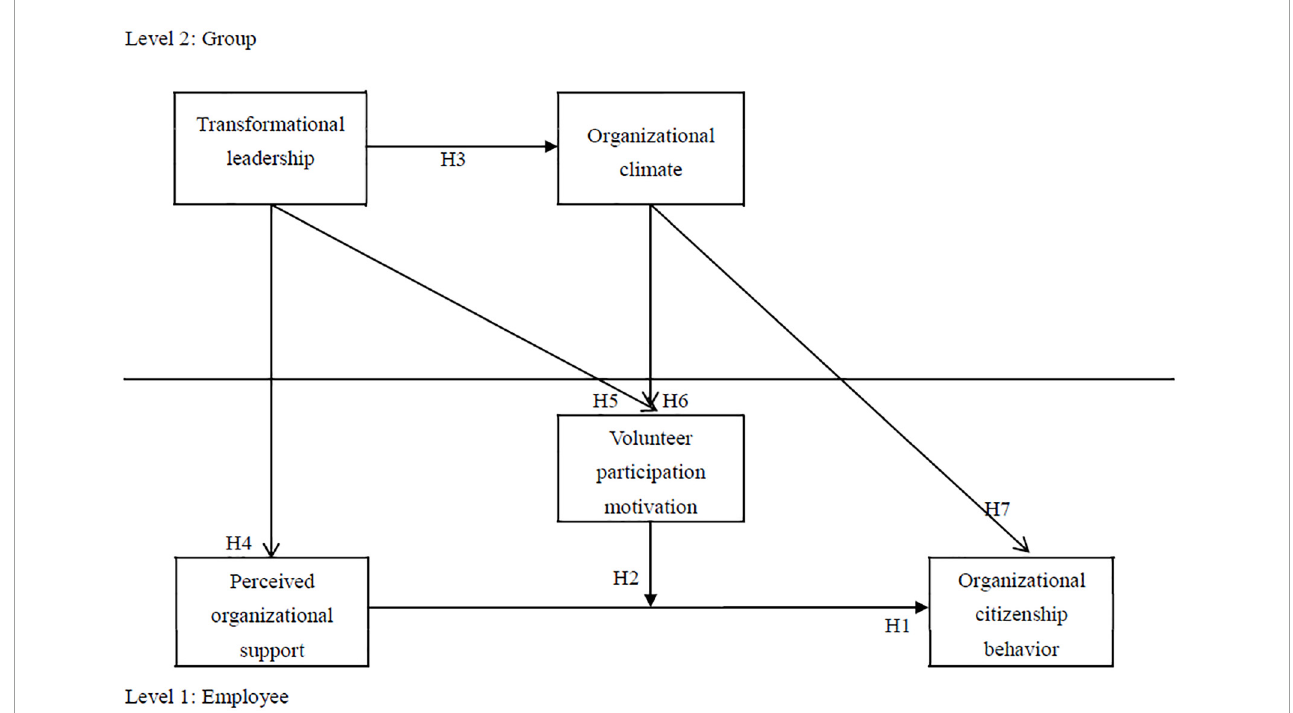
FIGURE1 Research